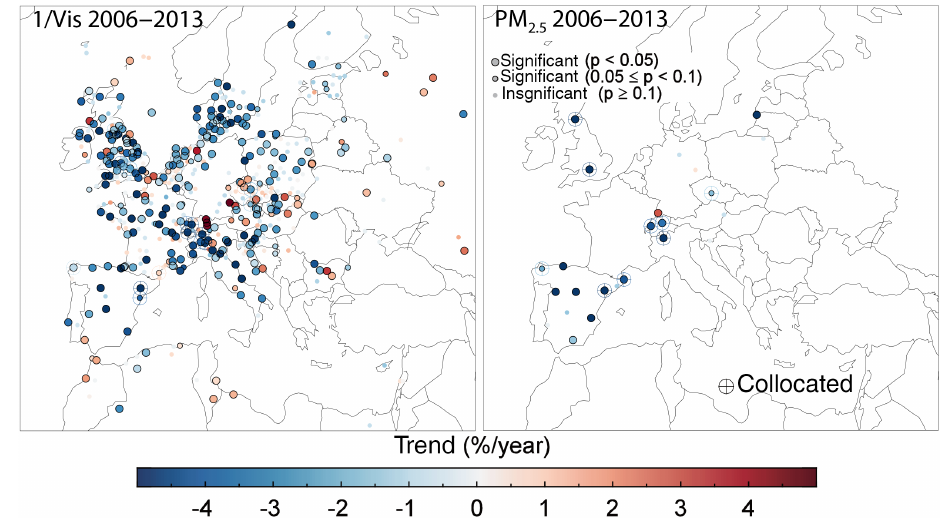
Figure 5. Spatial distribution of relative trends in 1/Vis and PM 2 . 5 over Europe for 2006–2013. Larger colored points with black outline indicate trends with at least 95% significance, smaller colored points with black outline represent trends with 90–95% significance, and colored points without outline indicate insignificant trends. Stations with cross and circle symbols are collocated between the ISD and EMEP networks for composite time series analysis in Fig.